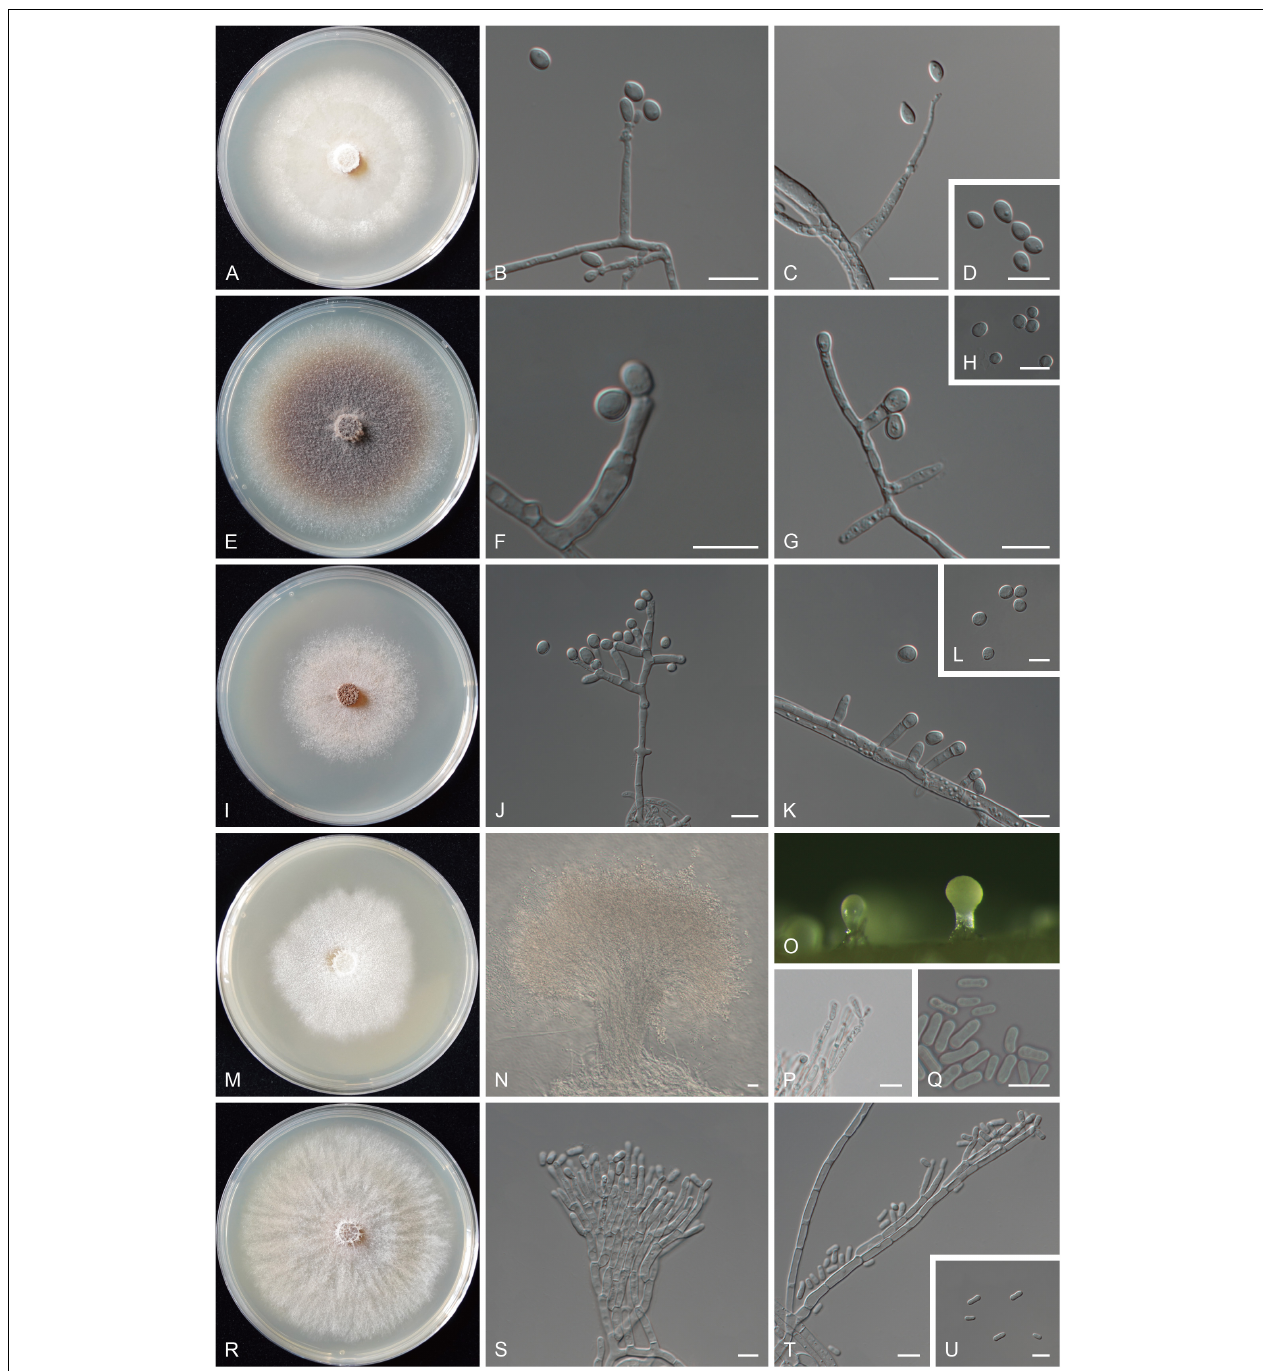
FIGURE 8 | Morphological characteristics of the five new species. (A–D) Morphological characteristics of O. huangnanense sp. nov. (taxon 1, CXY3004, holotype). (A) Fourteen-day-old cultures on 2% MEA. (B–D) Sporothrix-like asexual morph: conidiogenous cells and conidia. (E–H) Morphological characteristics of O. maixiuense sp. nov. (taxon 3, CXY3007, holotype) (E) Seven-day-old cultures on 2% MEA. (F–H) Hyalorhinocladiella-like asexual morph: conidiogenous cells and conidia. (I–L) Morphological characteristics of Ophiostoma sanus sp. nov. (taxon 4, CXY3012, holotype). (I) Seven-day-old cultures on 2% MEA. (J–L) Hyalorhinocladiella- to raffaelea-like asexual morph: conidiogenous cells and conidia. (M–Q) Morphological characteristics of L. sanjiangyuanense sp. nov. (taxon 6, CXY3021, holotype). (M) Ten-day-old cultures on 2% MEA. (N,O) Pesotum-like asexual morph. (P,Q) Conidiogenous cells of pesotum-like asexual morph and conidia. (R–U) Morphological characteristics of L. zekuense sp. nov. (taxon 7, CXY3025, holotype). (R) Ten-day-old cultures on 2% MEA. (S–U) Hyalorhinocladiella-like asexual morph: conidiogenous cells and conidia. Scale bars: panels (B–D,F–H,J–L,P,Q,S–U) = 10 µ m; panel (N) = 20 µ m.